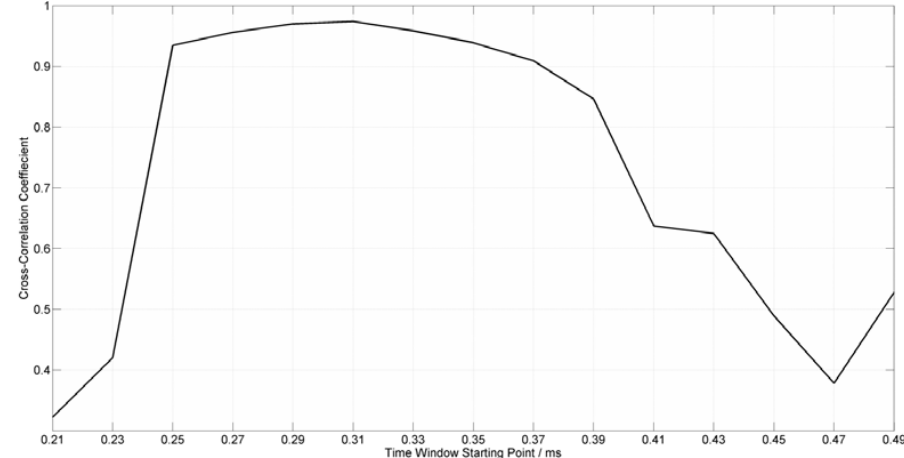
Figure 6. Moving window cross-correlation coefficient plot.